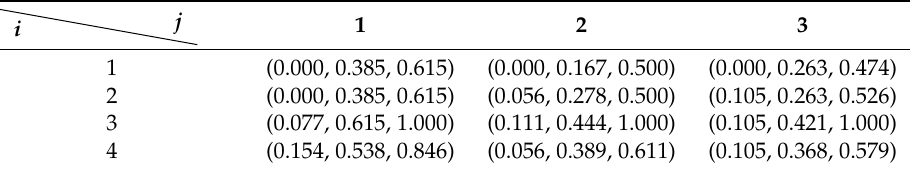
Table 6. Normalized triangular fuzzy numbers X i,j = ( a i,j , b i,j , c i,j ).